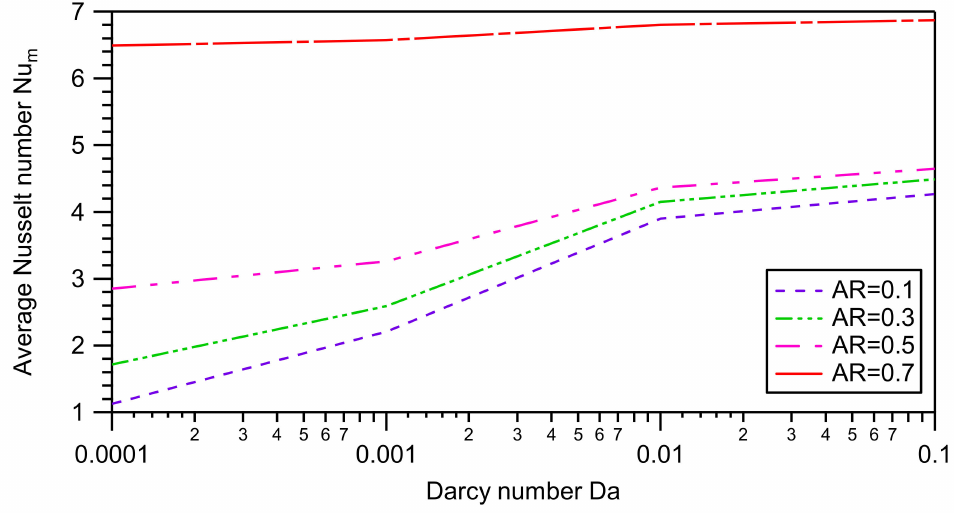
Figure 15. The average Nusselt number Nu m according to the Darcy number with di ff erent aspect ratios (AR = 0.1, 0.3, 0.5 and 0.7) with Ra = 10 5 , Ha = 15, ϕ = 0.04, Fr = 0.75, ω = 0 and q ∗ = 1.